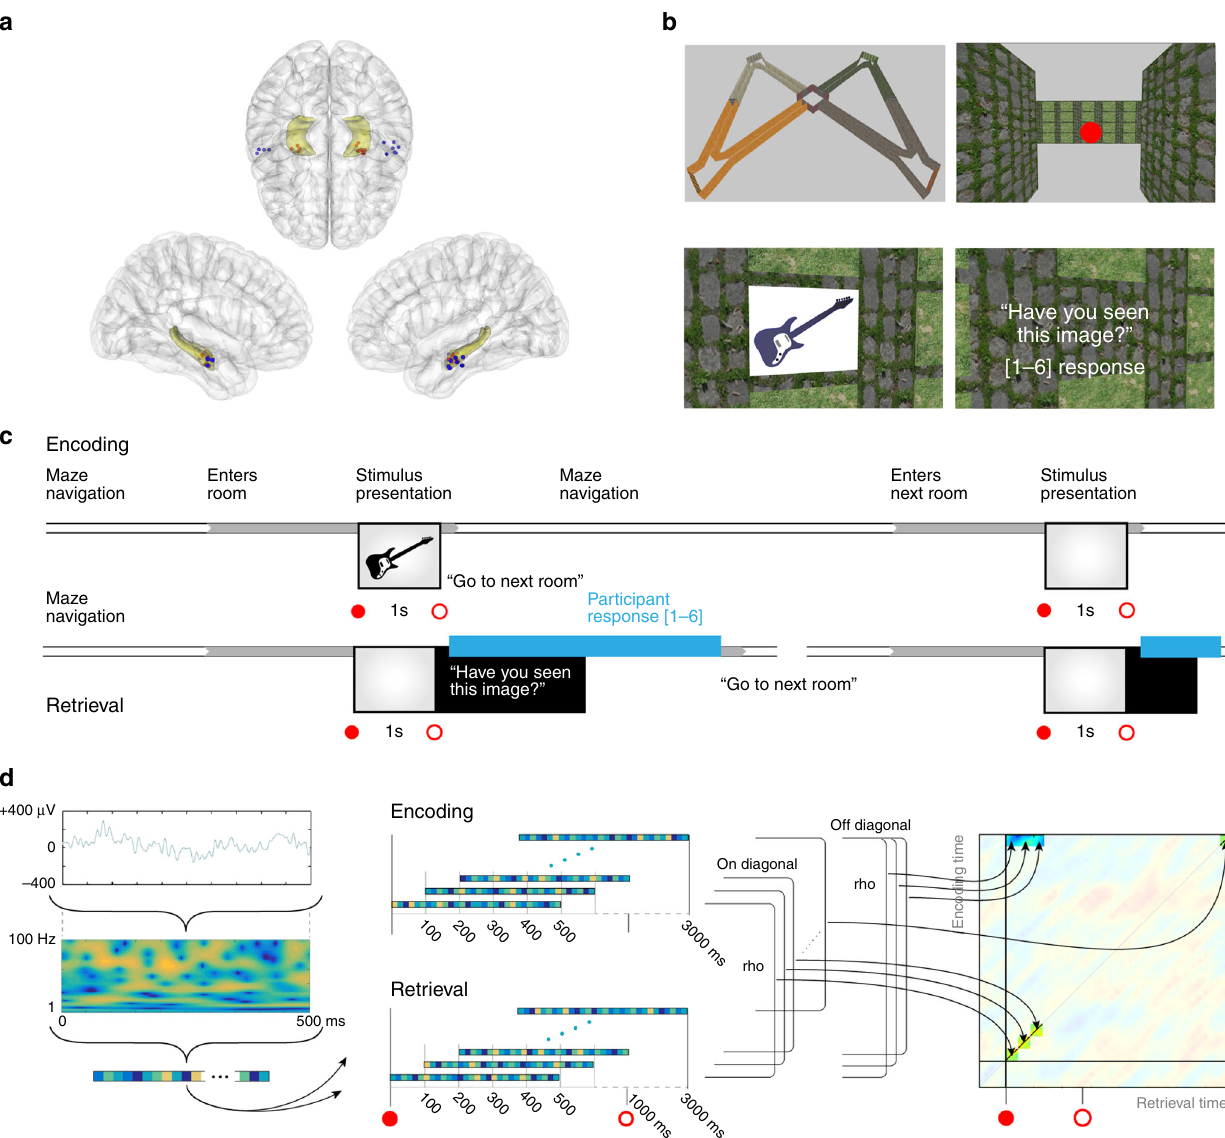
Fig. 1 Task description and reinstatement analysis. a Electrode placement. One hippocampal and one lateral temporal cortex electrode from the same hemisphere was selected in each patient. Figure shows the selected contacts from all patients in MNI space. b Experimental task: overview. Participants navigated a virtual maze (top left) and visited several rooms (top right) where visual item were presented (bottom left). During retrieval, participants conducted a recognition memory task (bottom right). Items were either presented in the same room (congruent condition) or in a different room (incongruent condition). c Experimental task: individual trials. Timeline of one example trial during the encoding and retrieval blocks. d Representational similarity analysis. Time-frequency patterns were extracted from individual electrodes (44 frequencies between 1 – 100 Hz), in time windows of 500 ms, overlapping by 400 ms. Reinstatement corresponded to Spearman ’ s correlations for all encoding-retrieval time